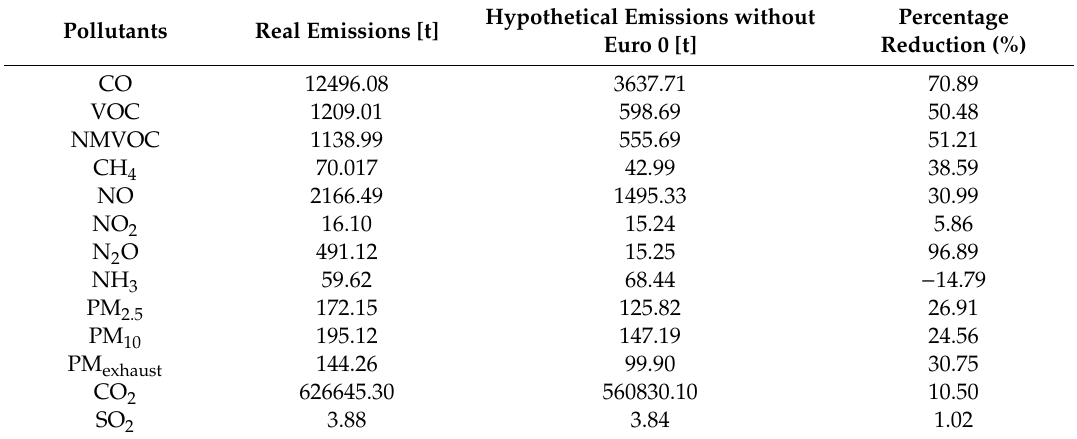
Table 3. Real and hypothetical emissions and the reduction in pollutants in the province of